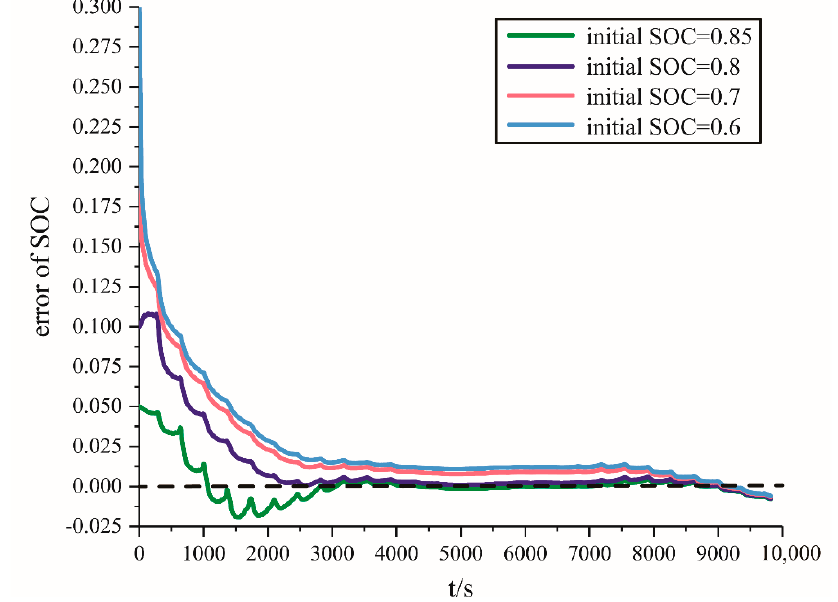
Figure 22. Comparison of SOC errors filtered by FEKF in different SOC initial errors under 26 continuous DST conditions at 28 °C.